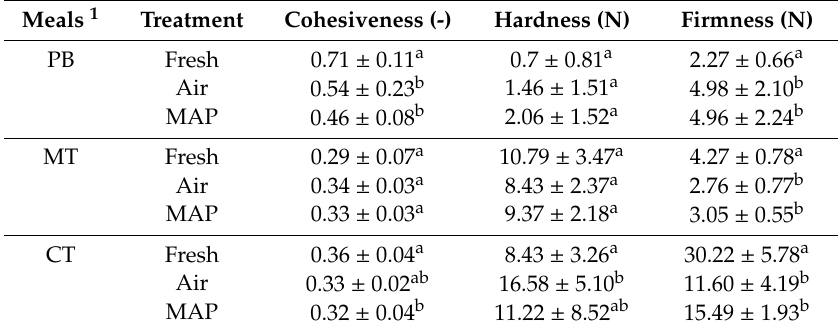
Table 6. Mechanical characterization of meals at 70 ± 5 ◦ C. For each meal, values in the same column with di ff erent letters are significantly di ff erent (Tukey’s LSD, p <